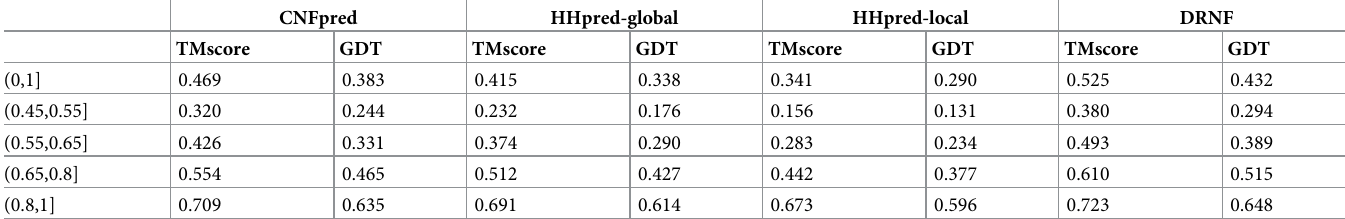
Table 2. Reference-independent alignment quality measured by TM-score and GDT on our in-house test set. GDT is scaled to [0, 1]. DRNF is trained by DeepAlign- generated alignments and uses Viterbi to build alignments.